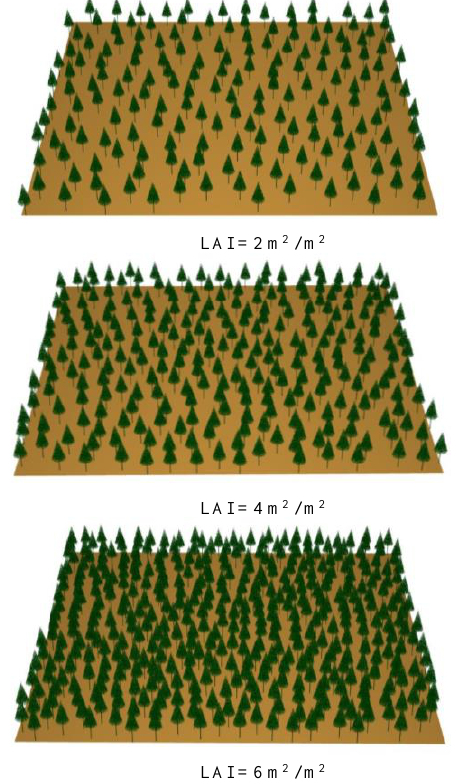
Figure 2. LAI scenarios based on LESS model